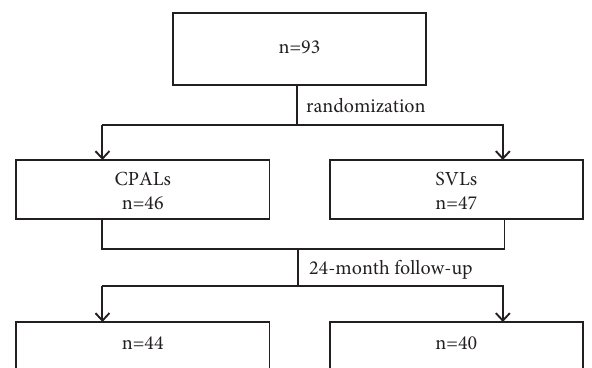
Figure 1: Study flow and random assignment of participants. CPALs, customized progressive addition lenses; SVLs, single vision lenses.